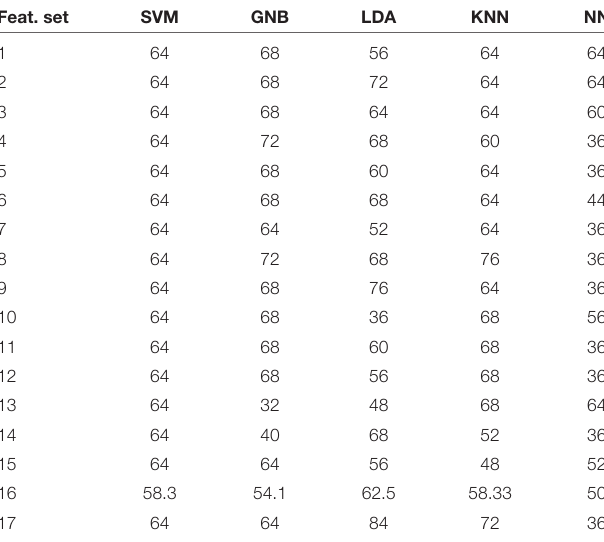
TABLE 9 | Performance of different models at different extracted features for phonation (P) podality obtained from AC channel. Feat.